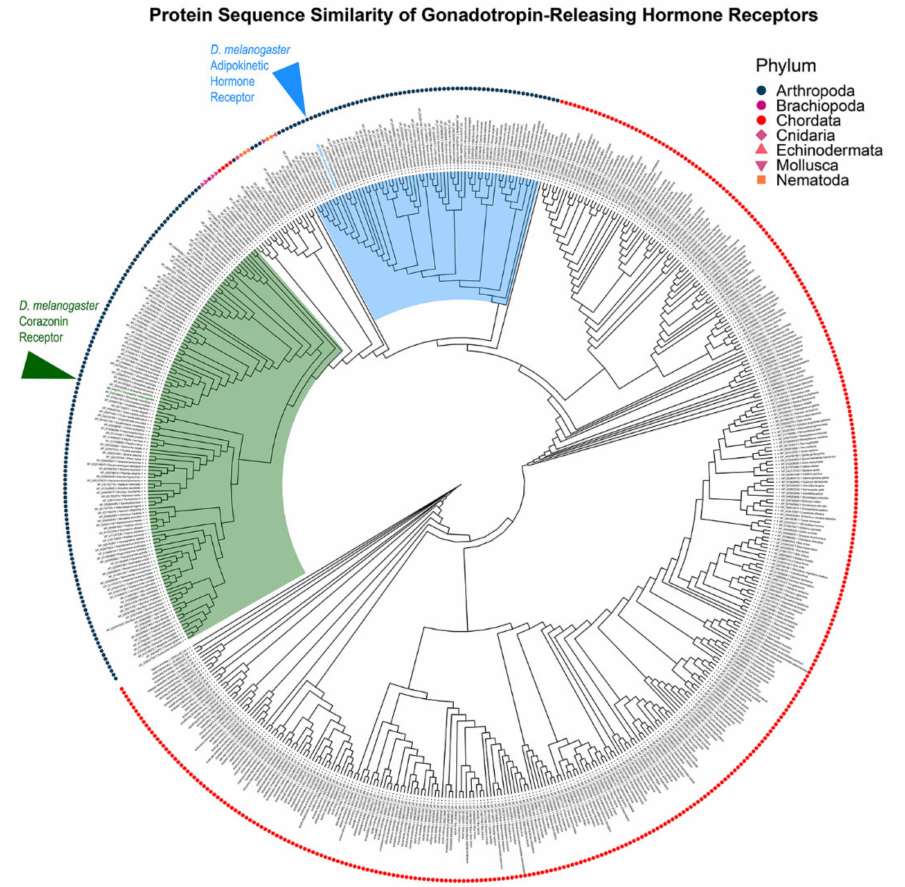
Figure 3. AKH signaling shares homology with gonadotropin releasing hormone signaling (GnRH). Cladogram depicting the protein sequence similarity between D. melanogaster’s AKH receptor (blue arrowhead), corazonin receptor (green arrowhead), and GnRH receptor reference sequences from NCBI protein. Arthropod GnRH receptors formed two major clusters, one containing AKH-like GnRH receptors (blue wedge) and the other containing corazonin-like GnRH receptors (green wedge). For each receptor, the source phylum is indicated by a symbol and labeled with the sequence accession number and species name. The source code and files for construction of the tree are available in a GitHub repository